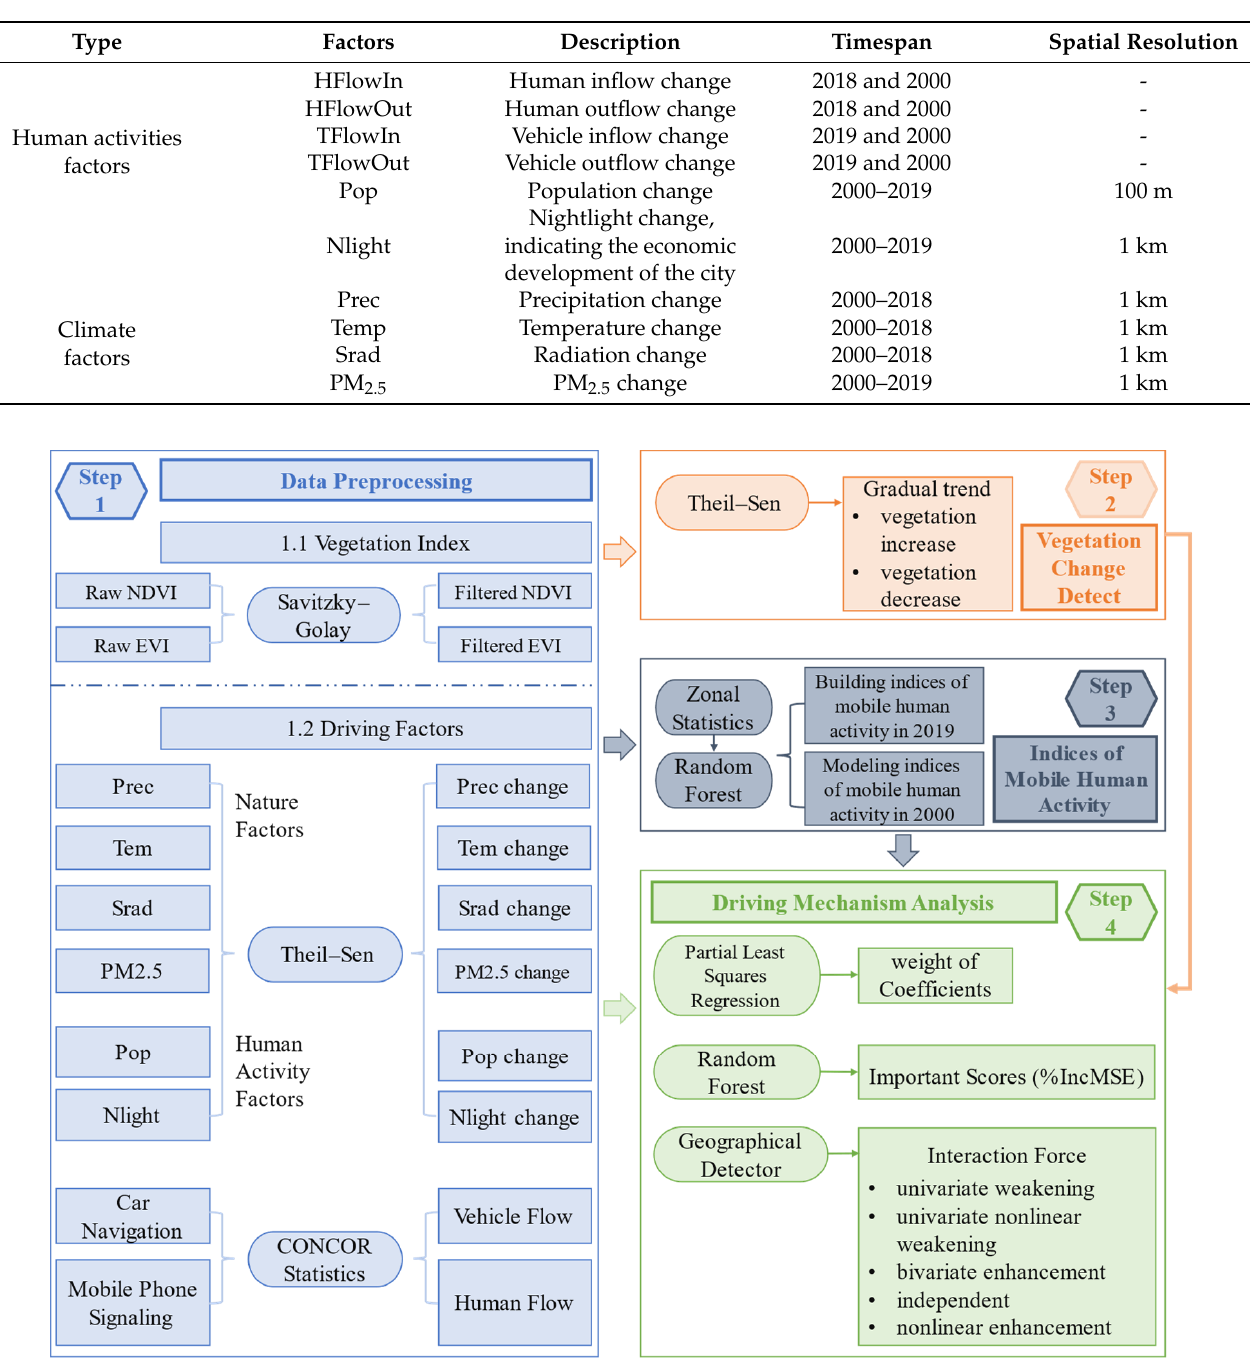
Table 1. Information about the driving factors.